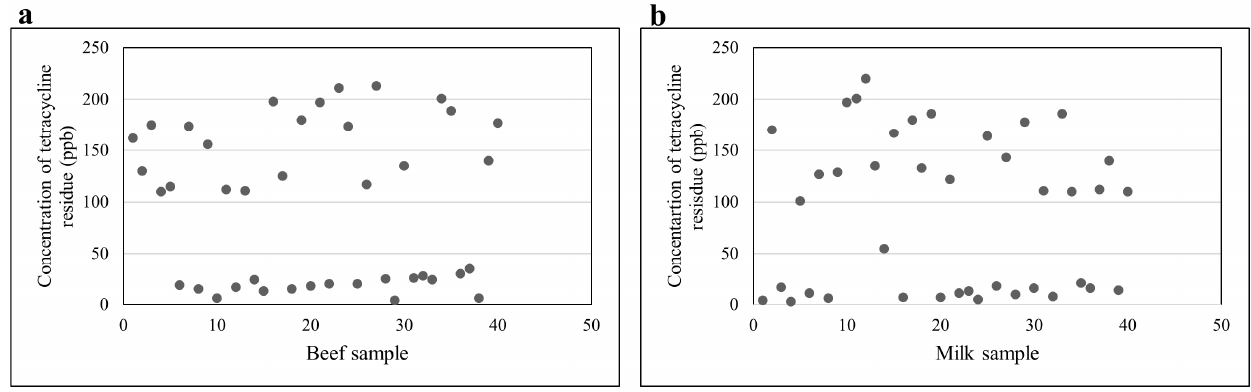
Figure 5. ( a ) Tetracycline residue in beef samples. ( b ) Tetracycline residue in bovine milk samples. 3.6. Coexistence of Antimicrobial Resistance, Antimicrobial Resistance Genes, and Tetracycline Residues in Bovine Milk and Beef Samples Twenty ‐ two of the 40 (55%) beef samples had tetracycline residue levels greater than 100 ppb; of these, 17 samples had a tet gene and 21 were tetracycline ‐ resistant. Twenty ‐ two of the 40 (55%) milk samples also tested positive for tetracycline residue at >100 ppb; of these samples, 20 were tetracycline ‐ resistant and 17 tested positive for the tet gene (Ta ‐ ble 5). Table 5. Coexistence of antimicrobial resistance, antimicrobial resistance genes, and tetracycline residues in bovine milk and beef samples